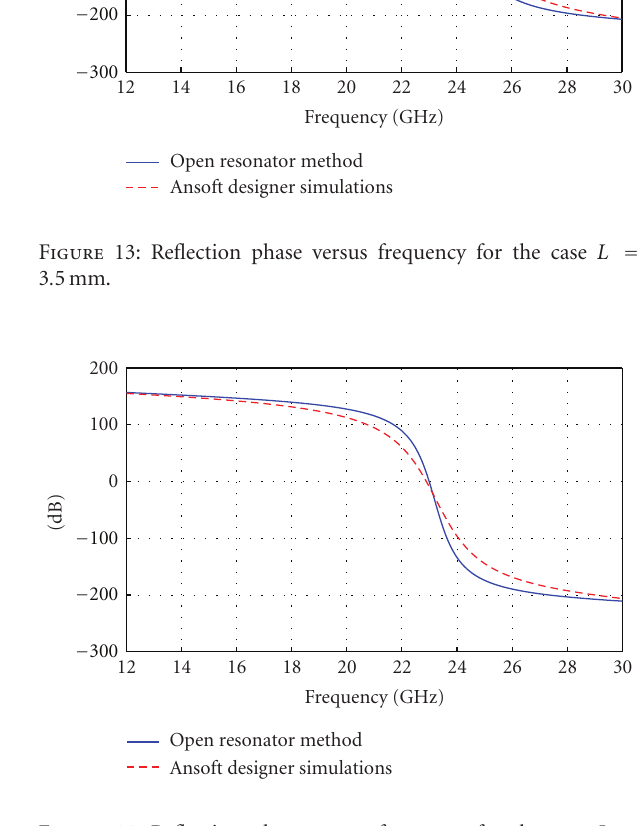
Figure 14: Reflection phase versus frequency for the case L = 3 .